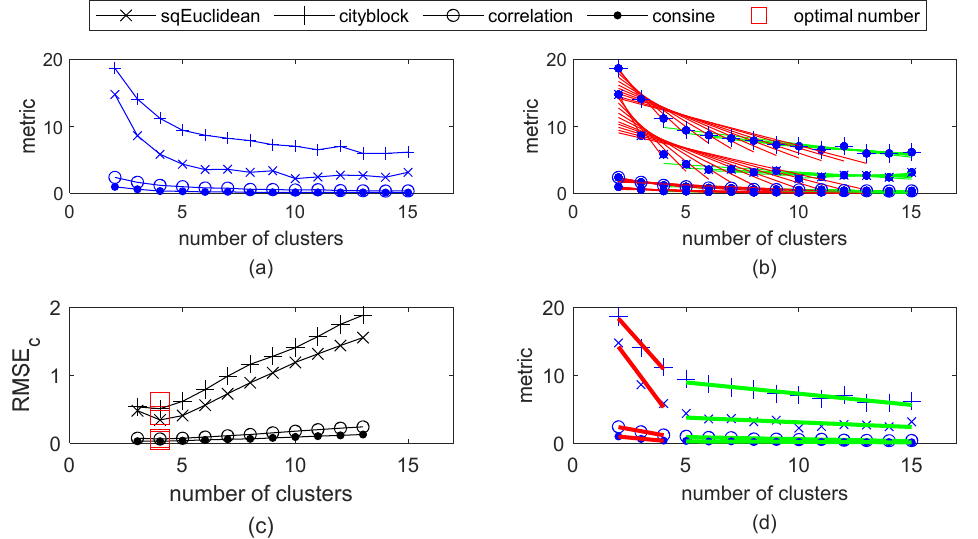
Figure 7. ( a ) Evaluation graph, ( b ) possible fitting lines, ( c ) RMSE, and ( d ) best-fit lines for city-block distance, Euclidean distance, correlation distance, and cosine similarity.